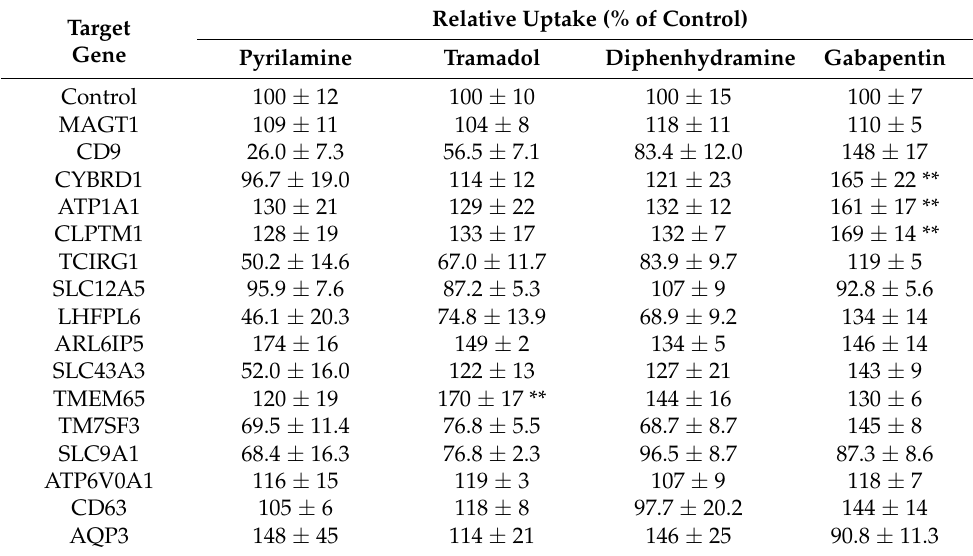
Table 2. First functional screening by single gene